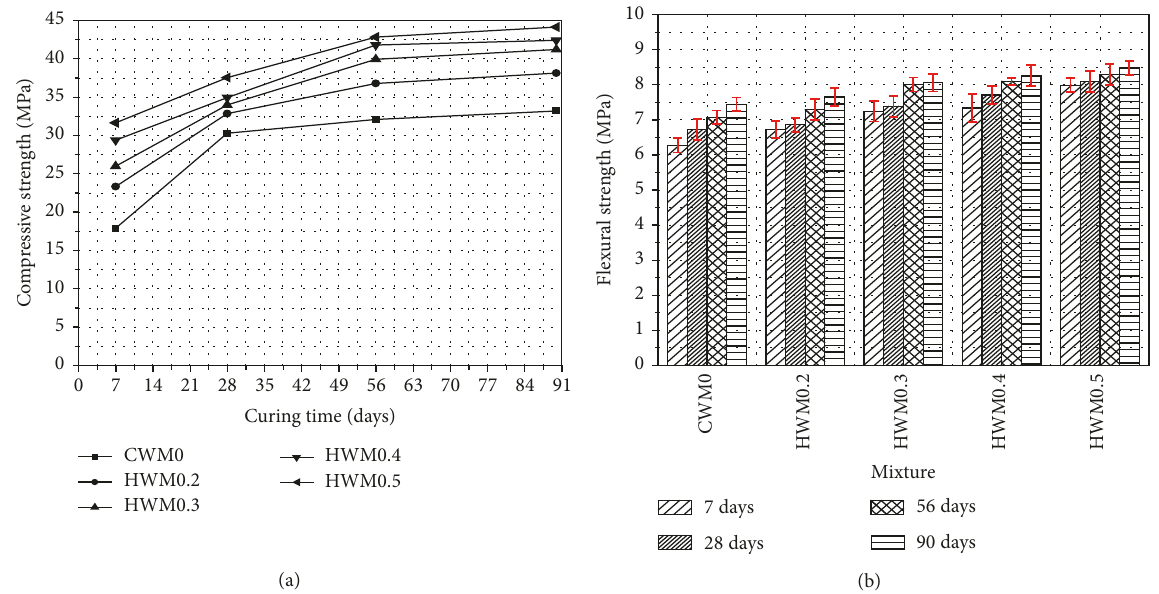
Figure 2: (a) Variation in the compressive strength of mortar mixtures with age. (b) Variation in the flexural strength of mortar mixtures with age.